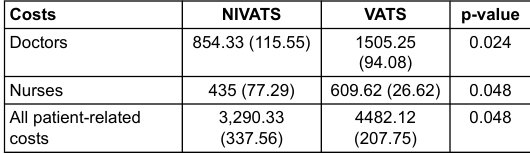
Table 4: Cost comparison between NIVATS and VATS sympathecto- my.